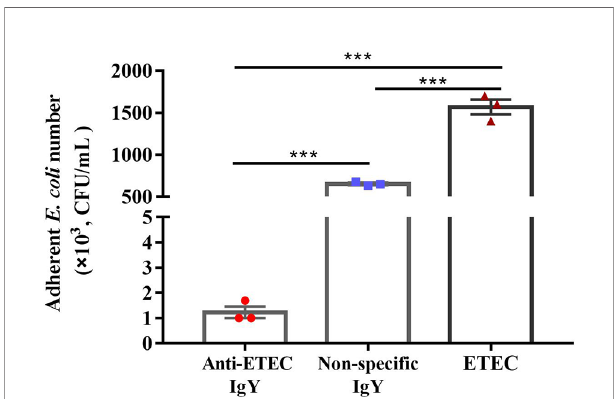
FIGURE 2 | Inhibitory effect of IgY on adhesion of ETEC K88 to IPEC-J2 cells. Before infection, ETEC K88 (2 × 10 8 CFU/mL) bacteria were pre- incubated with 5 mg/mL of anti-ETEC IgY, 5 mg/mL non-speci fi c IgY or PBS at 37°C for 1 h, respectively. ETEC K88 bounded to IPEC-J2 cells were